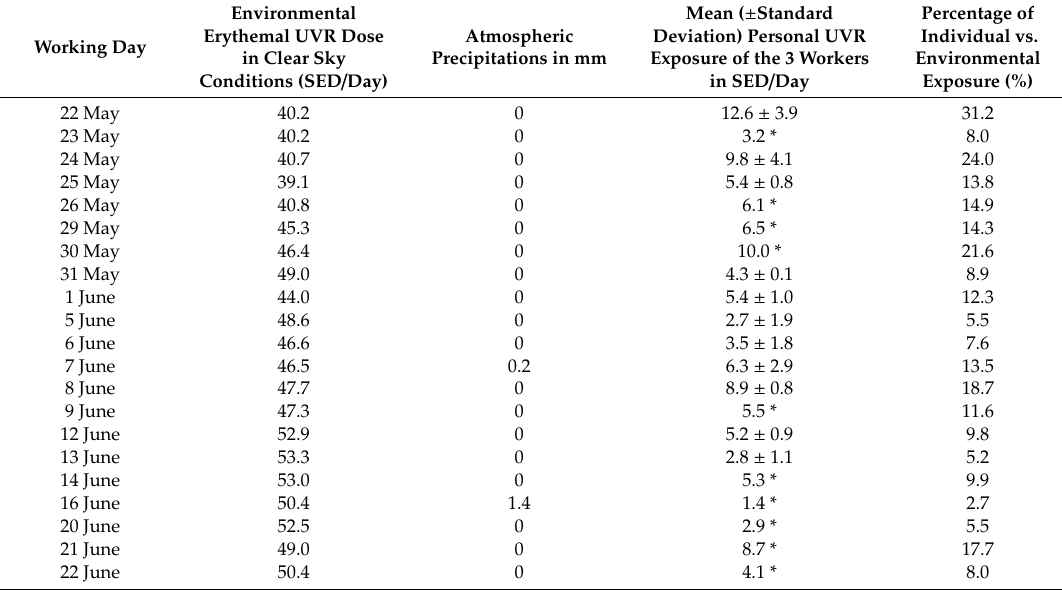
Table 3. Daily environmental erythemal UV dose in clear-sky conditions and mean individual occupational solar UVR exposure of the three construction workers in Tuscany during 21 working days (22 May–22 June 2017) in standard erythemal doses per day (SED / day), with atmospheric precipitations in the days considered and percentage of individual versus ambient